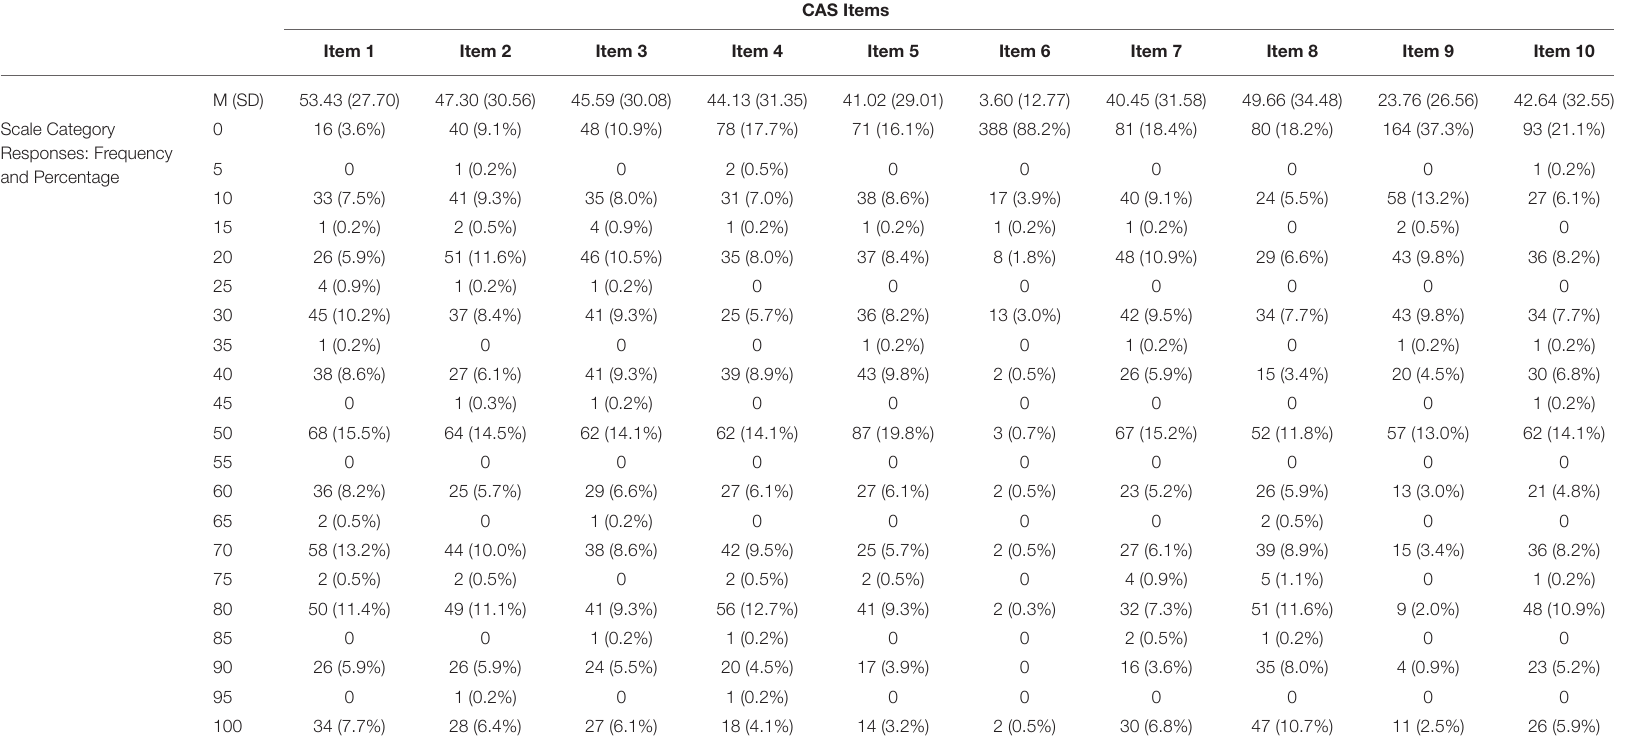
TABLE 2 | Descriptive statistics for the CAS-1R Items: Mean, Standard Deviation, frequency and percentage per scale category ( N =